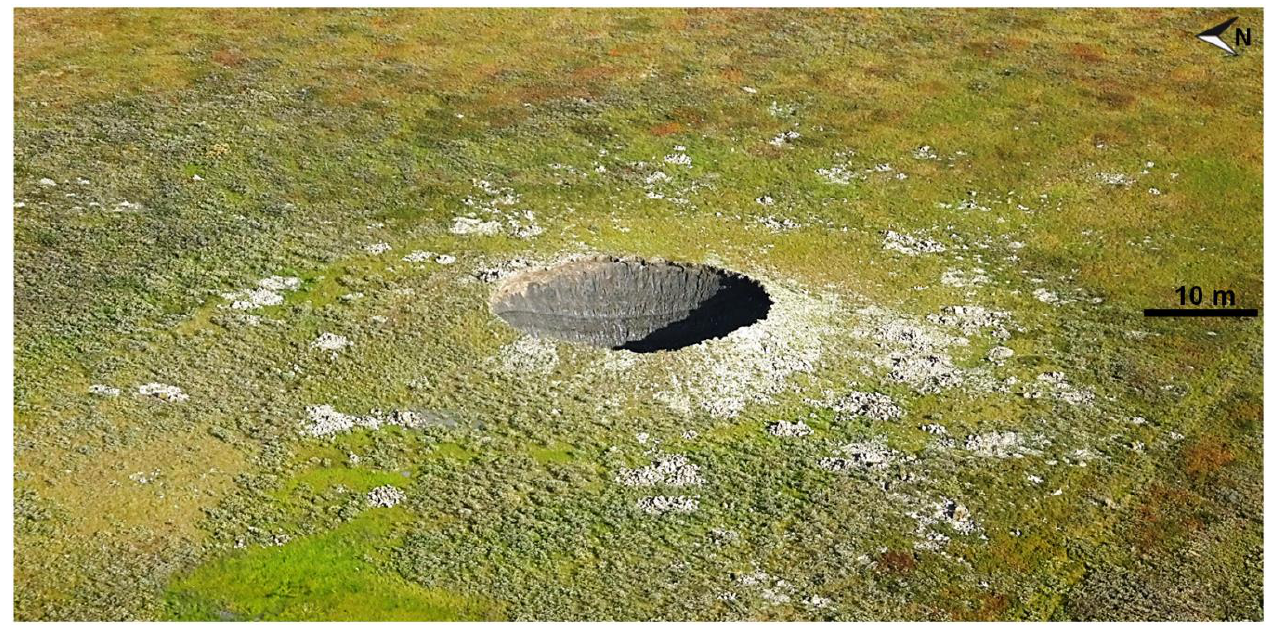
Figure 2. C17 crater (photo by Vasily Bogoyavlensky from the helicopter, August 26, 2020).